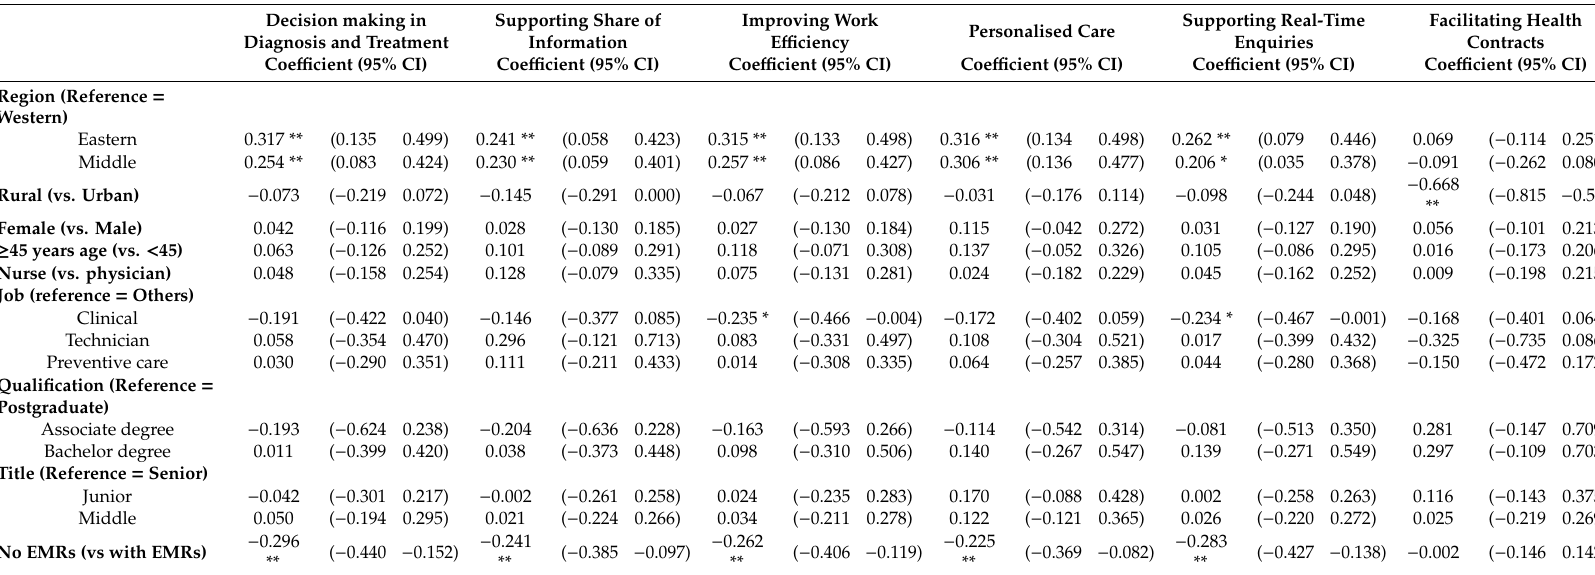
Table 4. Factors associated with the perceived value of electronic medical records: results of ordinal logistic regression models ( n = 2719). Decision making in Supporting Share of Diagnosis and Treatment